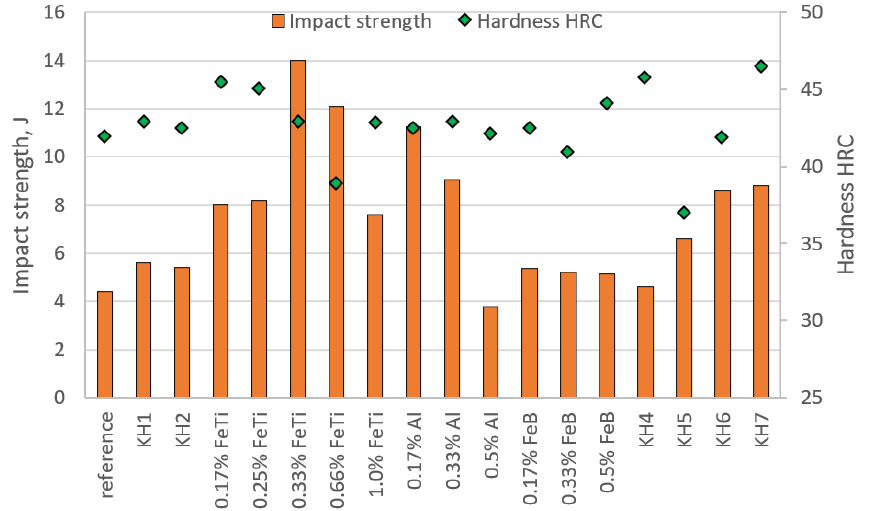
Figure 6. Results of toughness and hardness